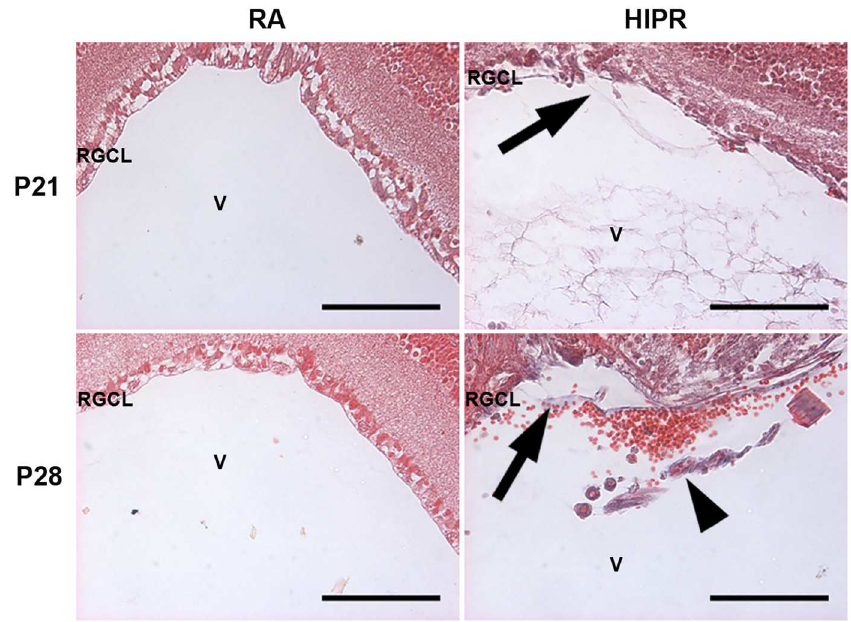
Fig 9. Collagen fibers found in hyperoxia-induced proliferative retinopathy. Retinal cross sectionswere stainedwith Masson’s trichrome (N = 3). Collagenfibers were detected in P21 and P28 HIPR retinas (arrows). Red blood cells were seen in the vitreous in the P28 HIPR with a nearbypersistent hyaloidalvessel (arrowhead). Scale bar, 100 μ m. RGCL, retinal ganglioncell layer. V, vitreous.